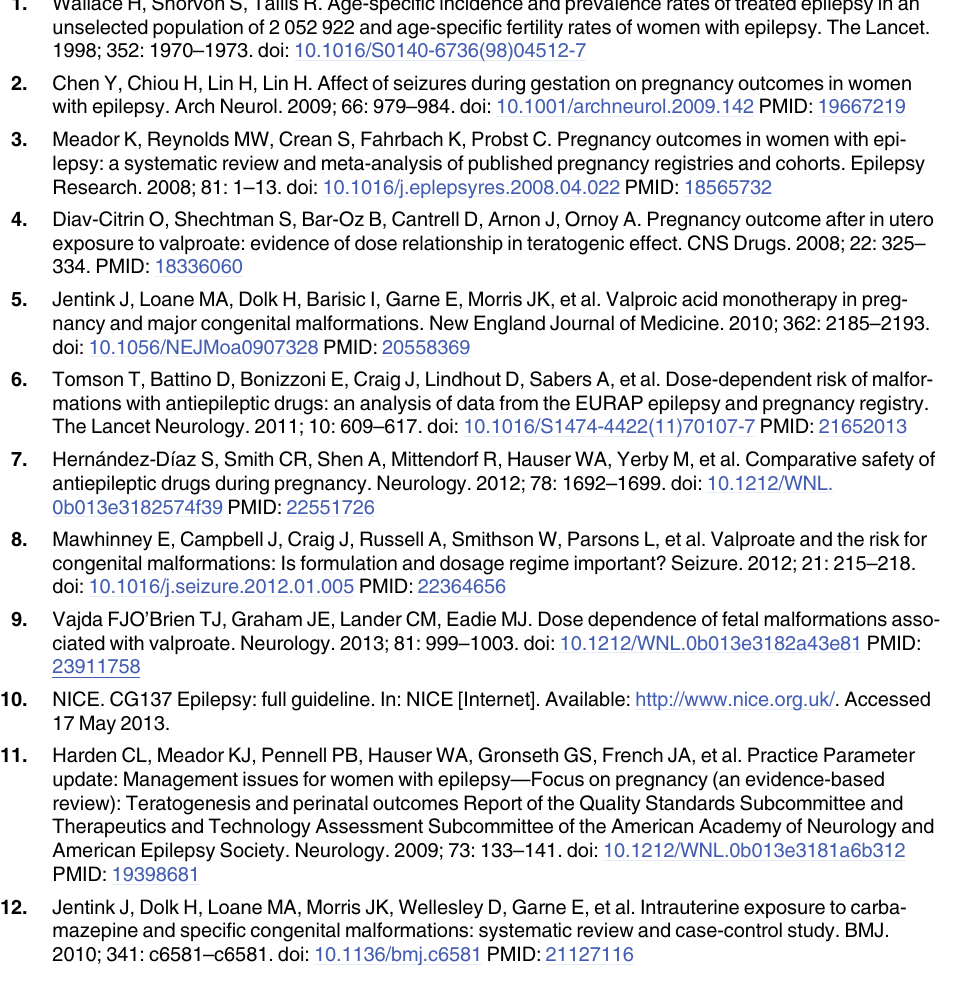
S2 Table. Adjusted odds ratios for the association of major congenital anomalies with indi- vidual antiepileptic drug types in the 1 st trimester of pregnancy and risk stratification